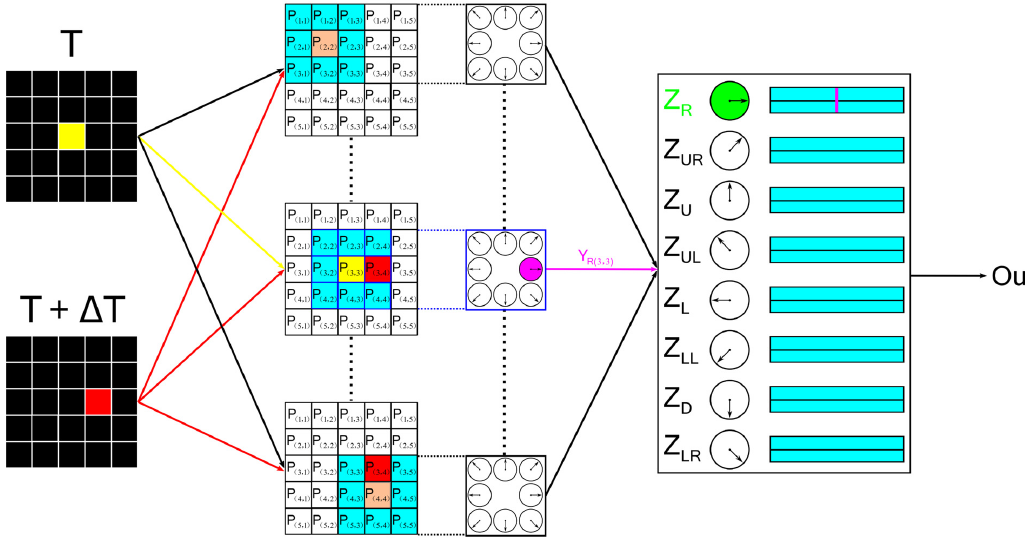
Figure 3. Flowchart of the AVS in detecting 1-pixel object.